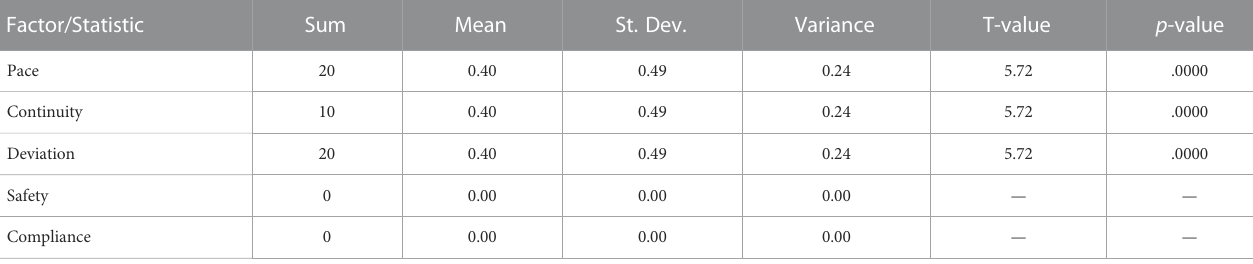
TABLE 6 Descriptive statistics of the performance factor in scenario 2: Pillars.